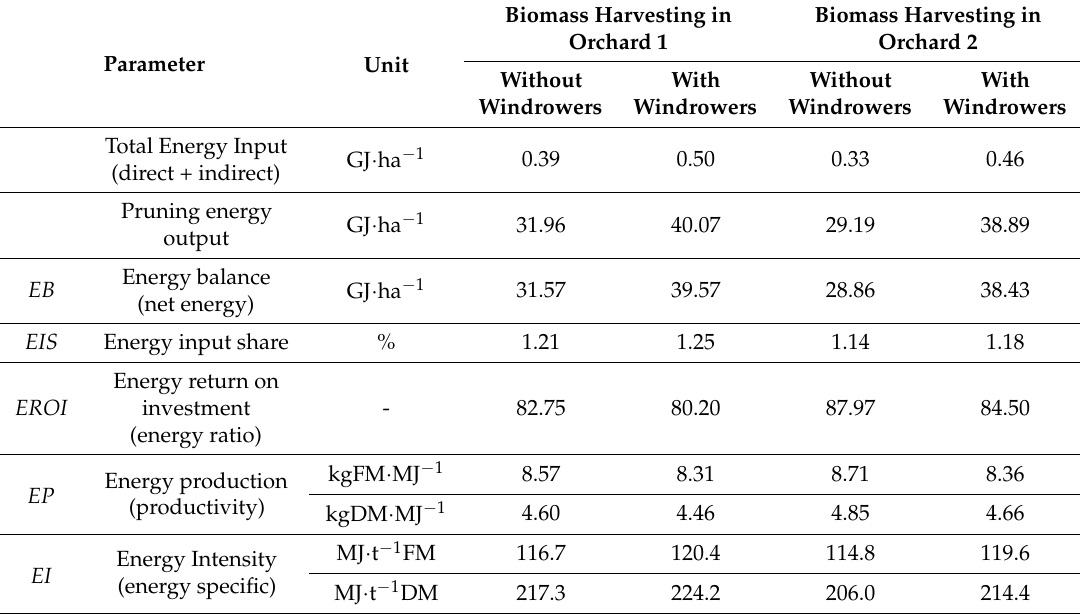
Table 5. Energy flows and indices for evaluated pruned biomass harvesting variants in the apple orchards.